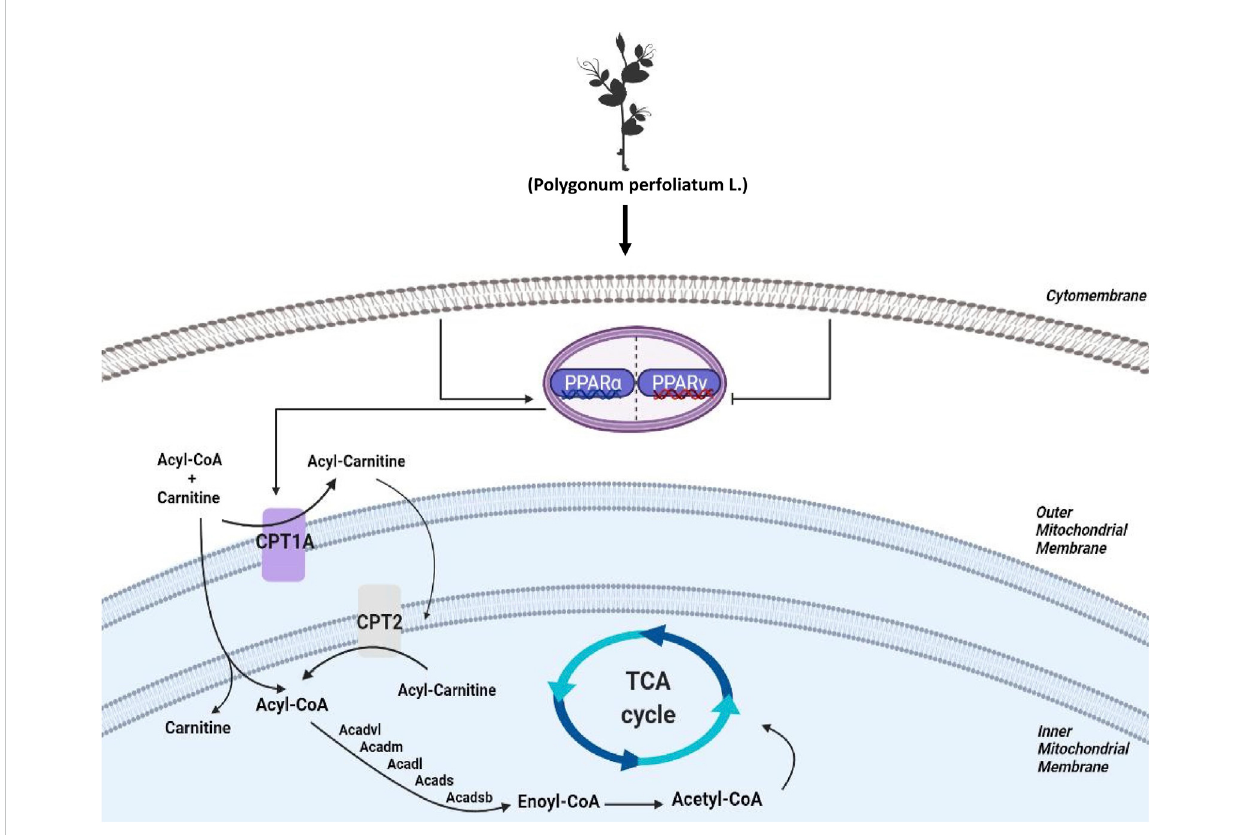
FIGURE 8 Schematic diagram depicting the role of FAO in the lipid-lowing effects of PPL. PPL signi fi cantly suppressed the expression of transcription factors PPAR γ ,promotedthetranscriptionallevelofPPAR α ,andsigni fi cantlyactivatedCPT1AandCPT2aswellasaseriesofAcetyl-CoenzymeAdehydrogenase that promote fatty acid β -oxidation, thus ameliorating obesity, NAFLD and insulin